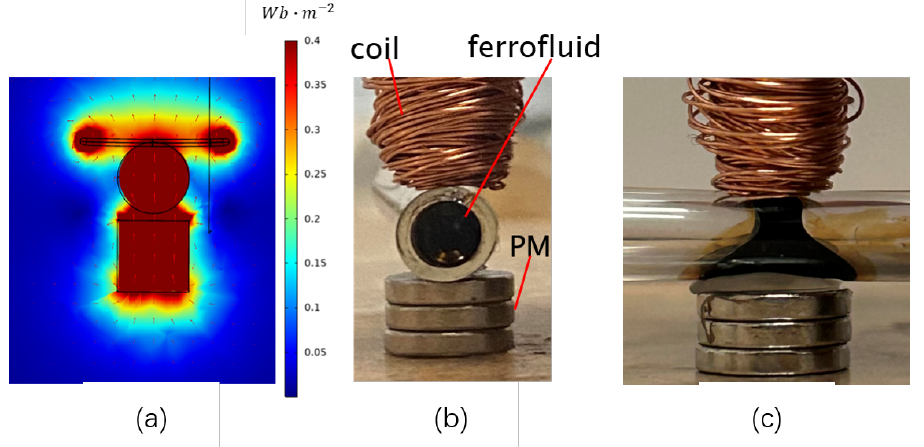
Figure 8. Magnetic-flux distribution and ferrofluid shape with excitation. ( a ) Simulation model for magnetic flux. ( b ) Experimental shape of ferrofluid with non-optimised coils (front view). ( c ) Side view of